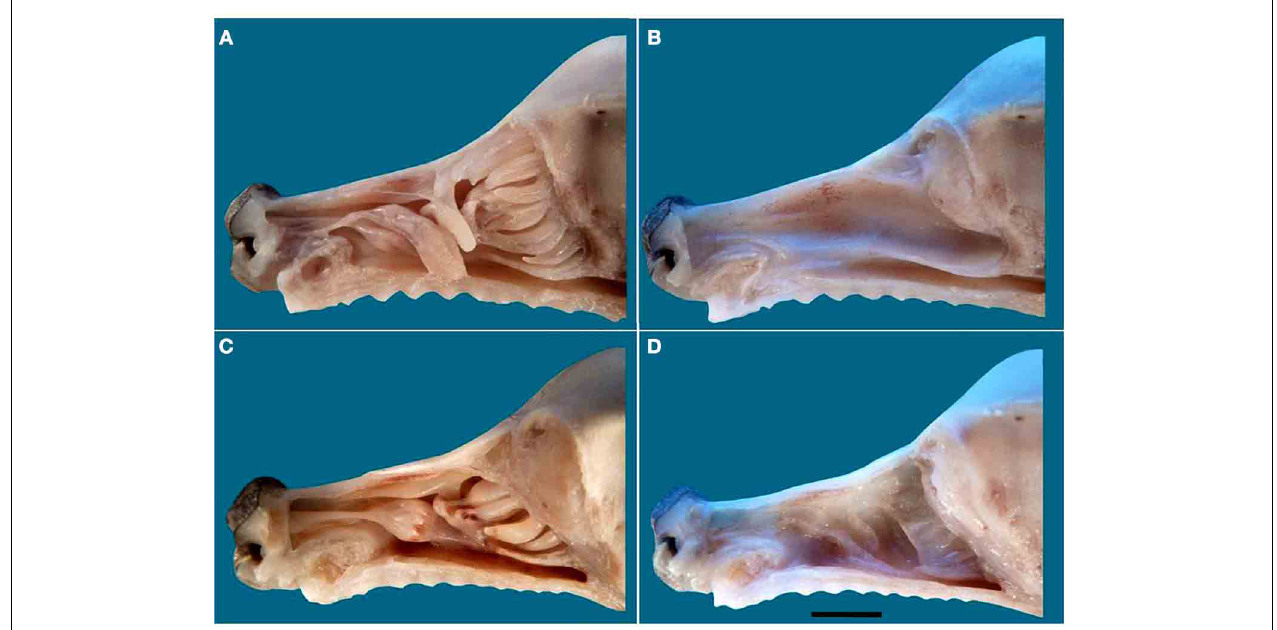
FIGURE 7 | The nasal cavity of the newborn dog. (A) Lateral view of the turbinate complex. (B) Lateral view of the nasal septum. (C) Medial view of the turbinate complex. (D) Medial view of the lateral wall. Scale bar: 1cm (see Figure